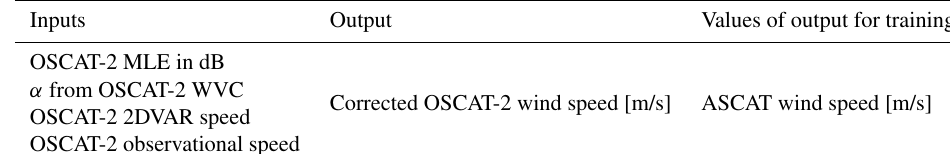
Table 1. Inputs and outputs for the SVM of wind speed correction.